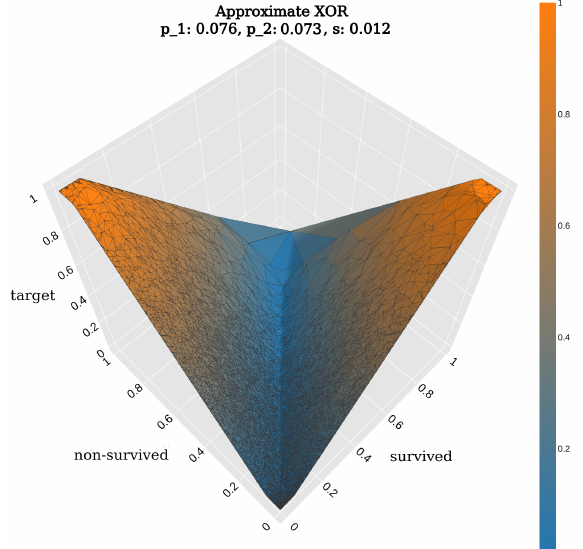
Figure 6. The approximated XOR data with the use of p 1 = 0.076, p 2 = 0.0731, s = 0.012 according to Equation